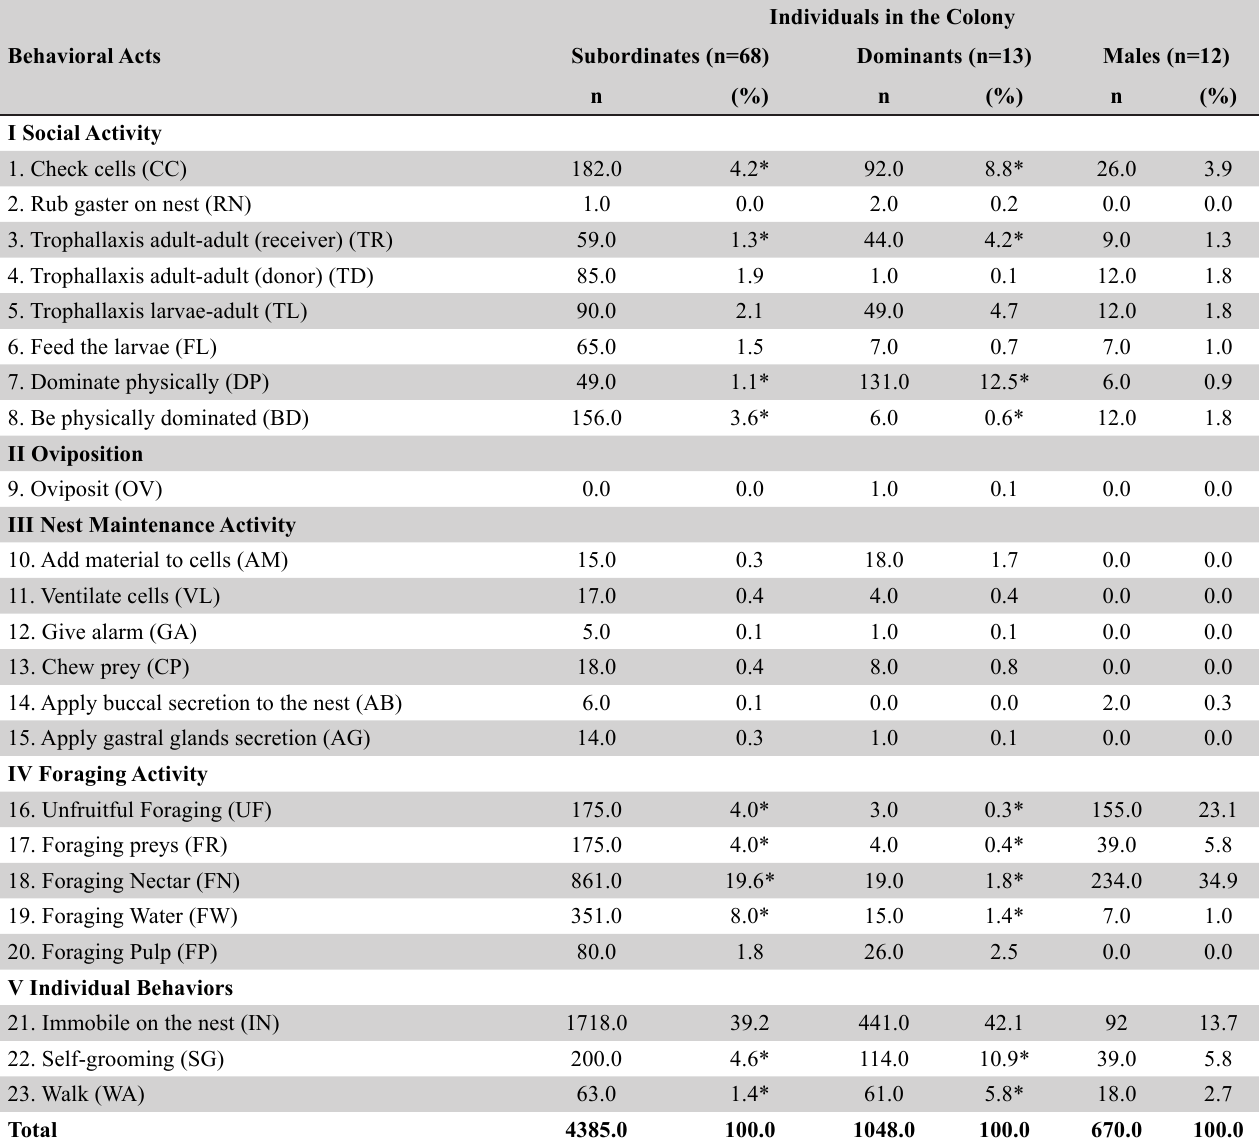
Table 1 . Ethogram of females (subordinates and dominants) and males of Mischocyttarus latior (Fox, 1898).